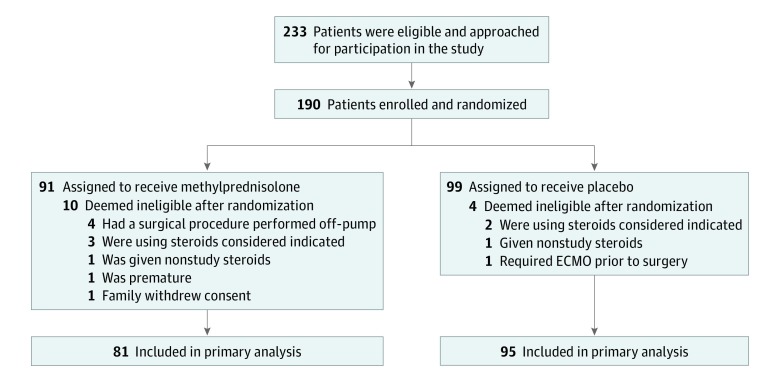
Parent Study Flow ChartECMO indicates extracorporeal membrane oxygenation.